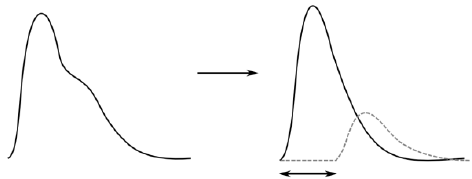
Figure 2. Forward pulse wave is higher in amplitude, while backward wave is lower in amplitude and shifted in phase.